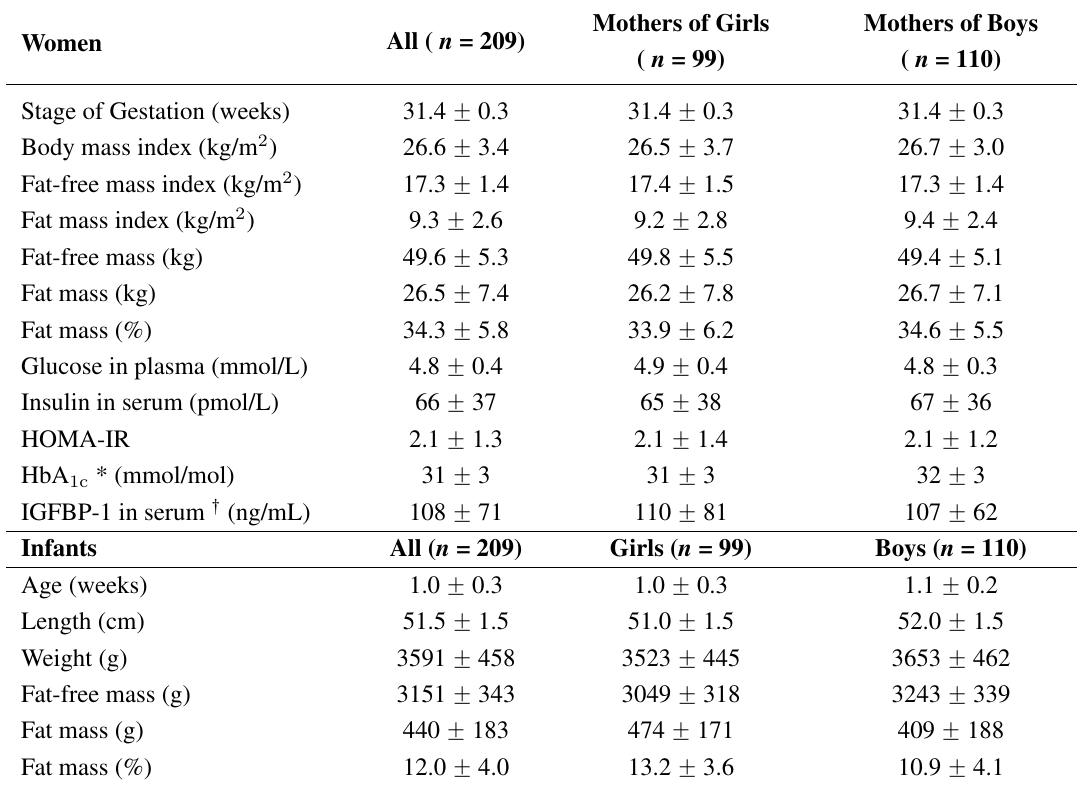
Table 1. Characteristics of women and infants at the times of